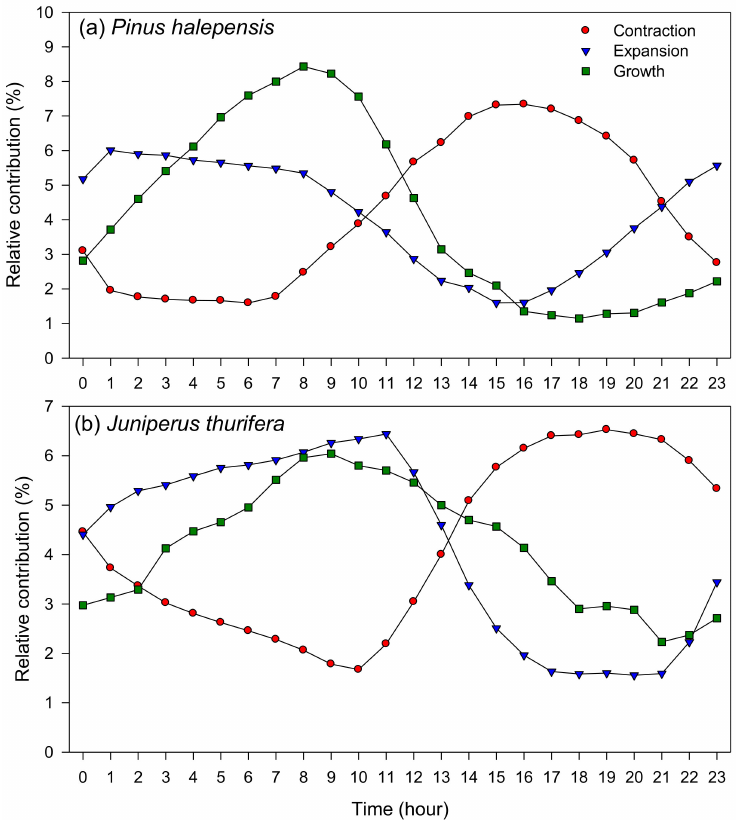
Figure 5. Contraction, expansion, and growth hourly phases based on dendrometer data corre- sponding to two study species (( a ), P. halepensis ; ( b ), J. thurifera ) from the Peñaflor study site. Data correspond to months when most IADFs are formed (August to September) and were obtained in the Peñaflor site during the period 2009–2011.